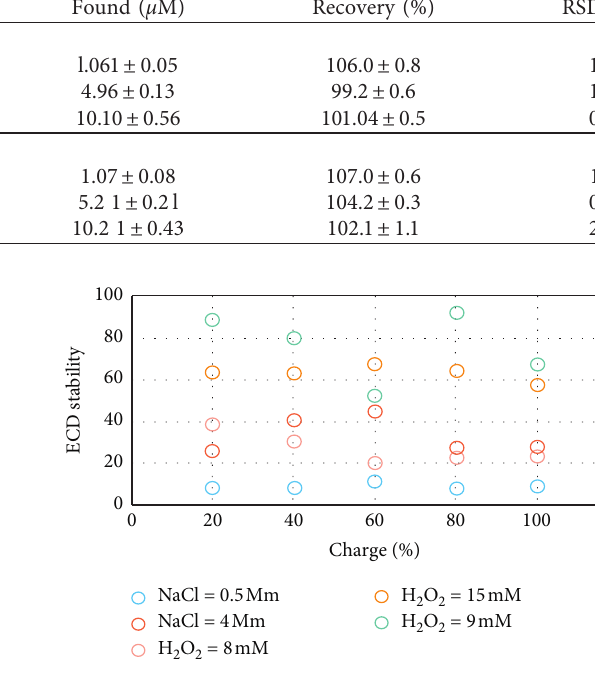
Figure 2: Results of 100ns interaction between carbon nano- particles with different charge ratios and the real cell membrane model ECDs